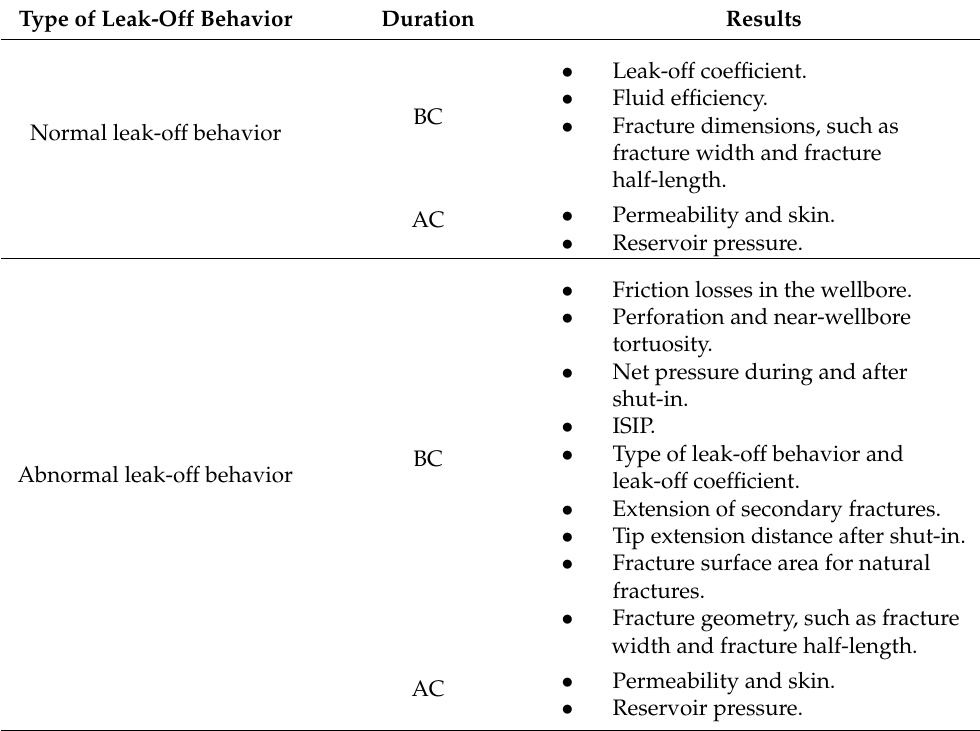
Table 6. DFIT’s outcomes from several field